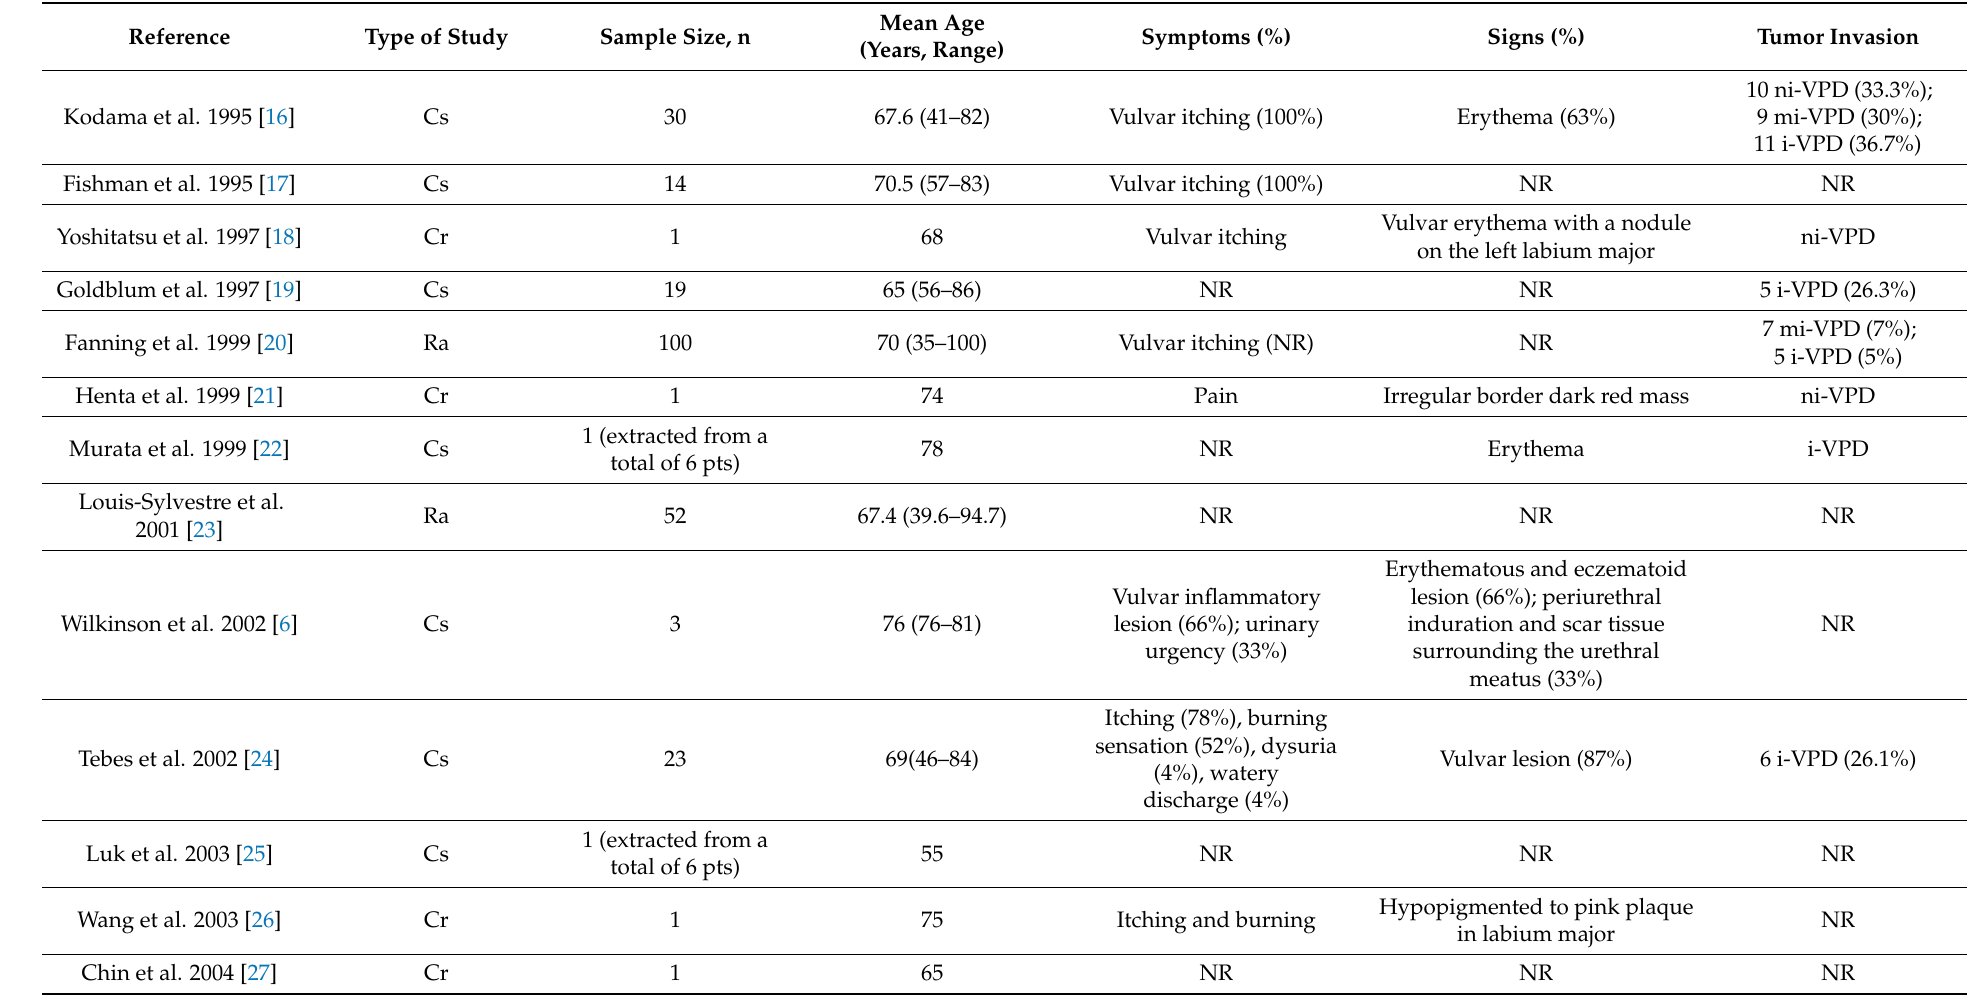
Table 1. Main characteristics of the included